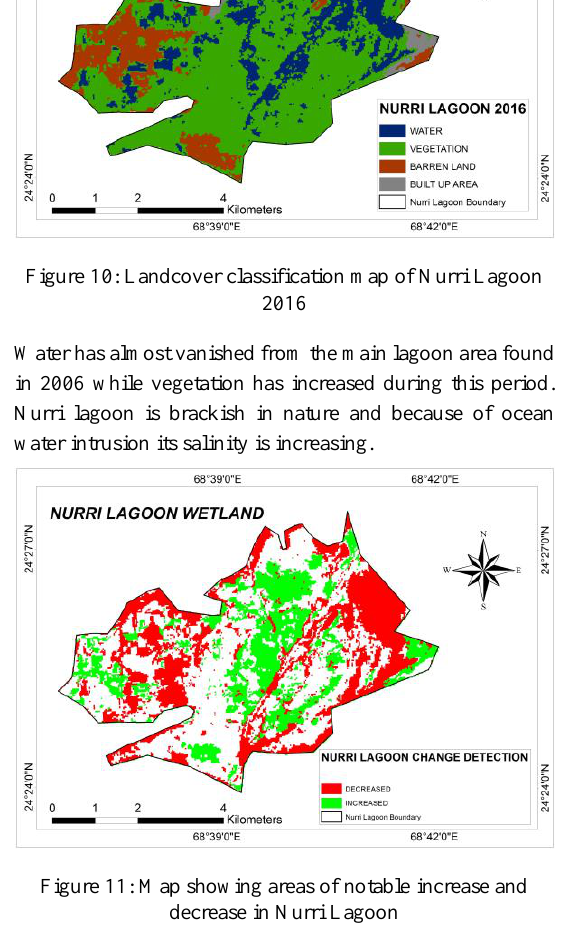
Figure 11: Map showing areas of notable increase and decrease in Nurri Lagoon